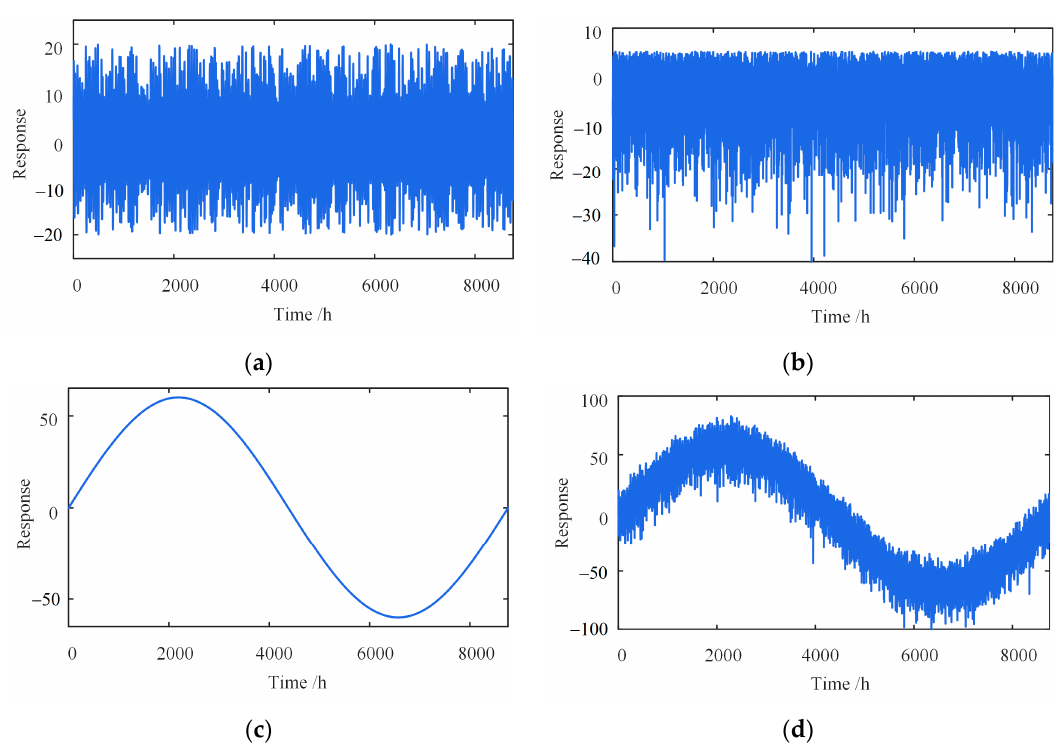
Figure 7. Different types of simulated signals (one year). ( a ) Daily temperature-induced response; ( b ) traffic-induced response; ( c ) seasonal temperature-induced response; ( d ) mixed signals. Table 2. Various calculation parameters.